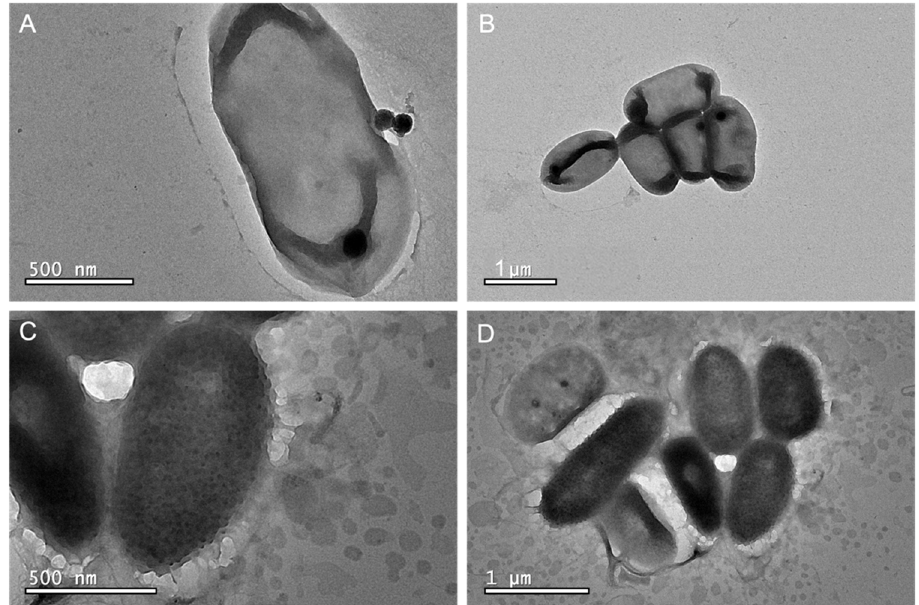
Figure 5. TEM images of uranyl acetate stained AB9 cells showing clear transparent membrane ( A , B ). QDs-Aptamer targeted bacteria show the QDs covering the membrane of the cells ( C , D